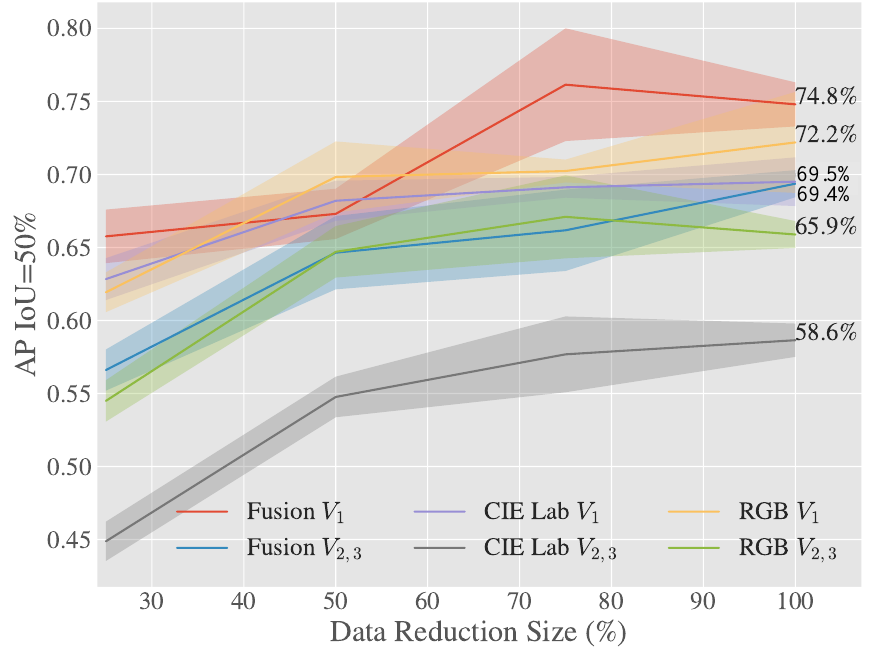
Figure 7. Average Precision for 50% intersection over union on V 1 and V 2 + V 3 validation data sets.